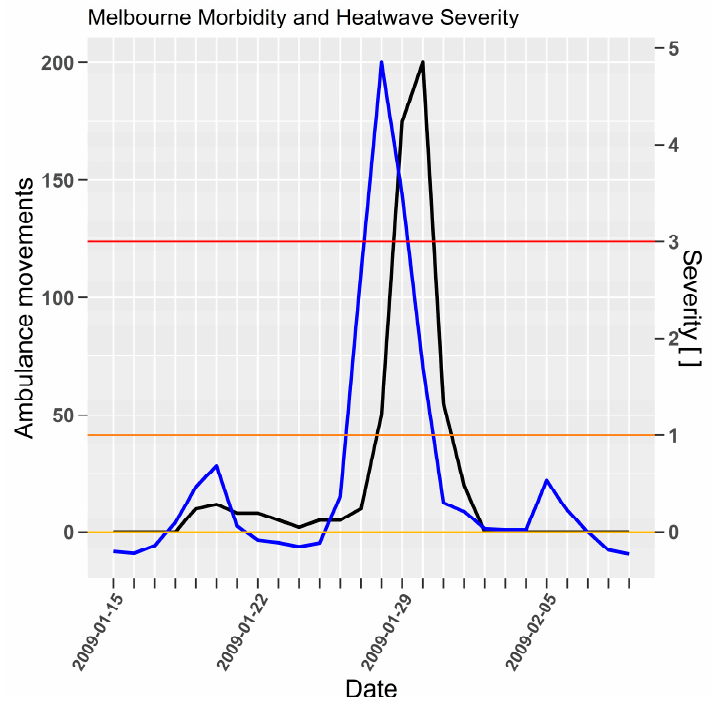
Figure 2. Heat related morbidity (ambulance movements, black line, left axis) and EHF severity (blue line, right axis) for Melbourne 2009 extreme heatwave [35] (p. 22).